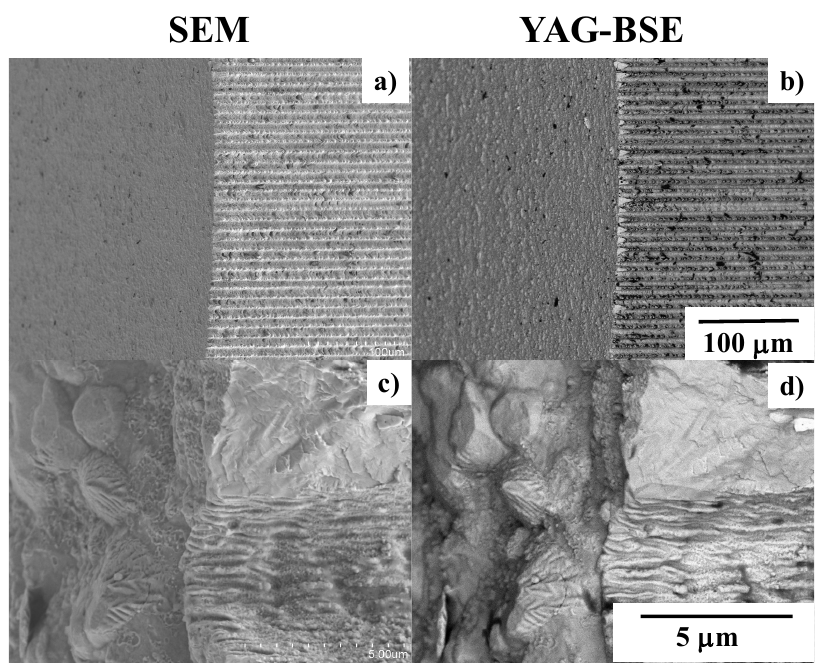
Figure 16. SEM and YAG-BSE images on the top and side punch surfaces across their edges after continuously piercing in 10,000 shots. ( a , b ) Low magnification, and ( c , d ) high magnification.